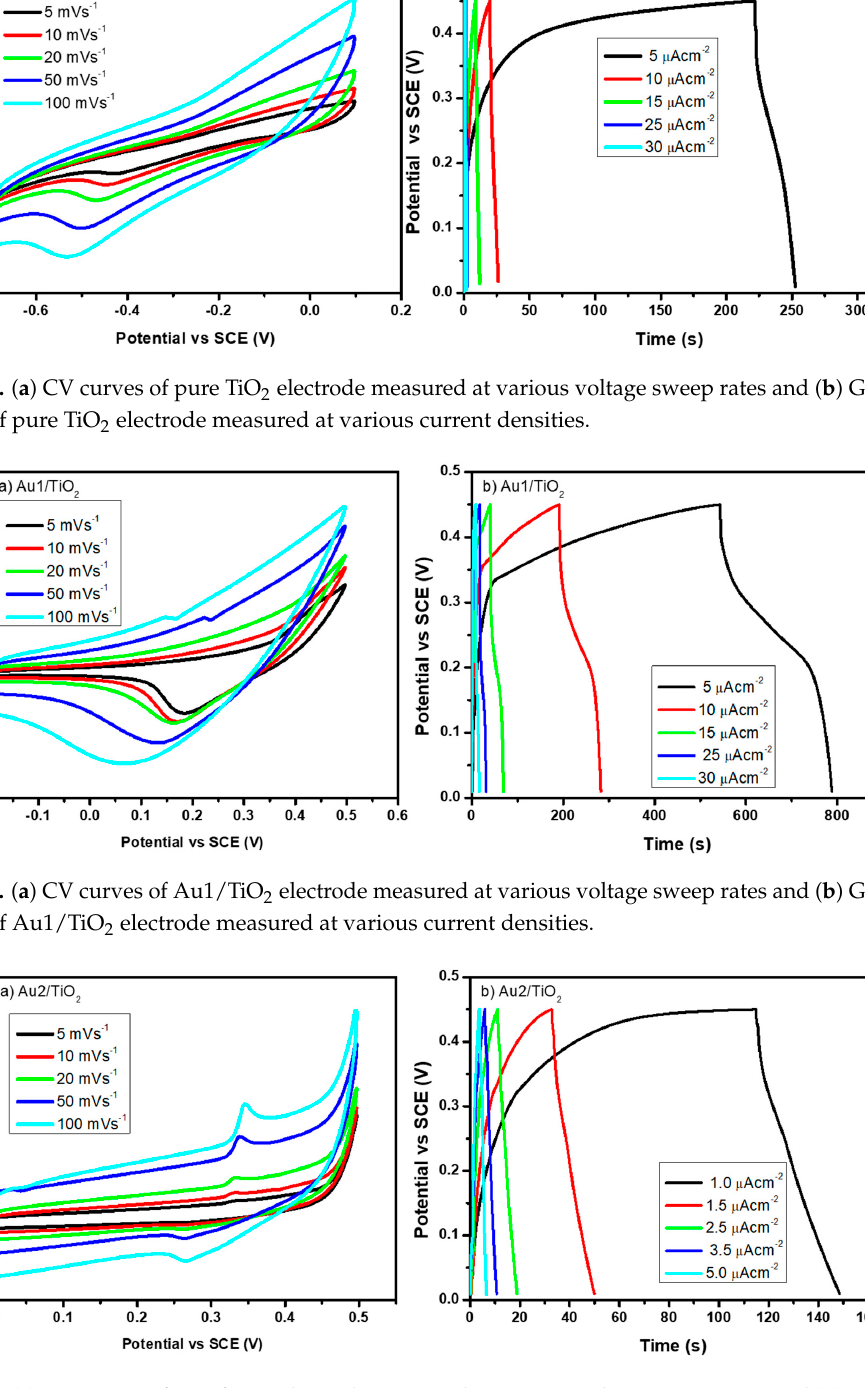
Figure 8. ( a ) CV curves of Au2/TiO 2 electrode measured at various voltage sweep rates and ( b ) GCD curves of Au2/TiO 2 electrode measured at various current densities.